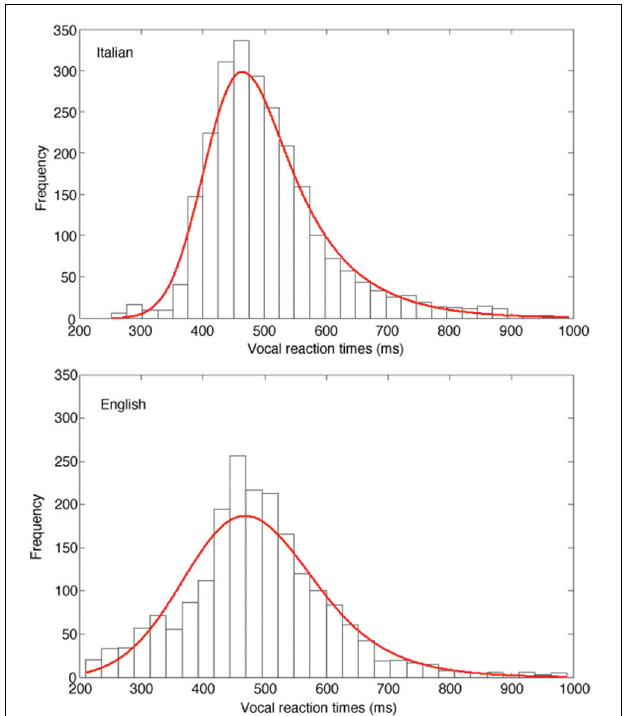
FIGURE 3 | Frequency distribution of vRTs of the Italian (upper panel) and the English (lower panel) sample. The red solid lines represent the best fit of the ex-Gaussian distributions of the data obtained by the two